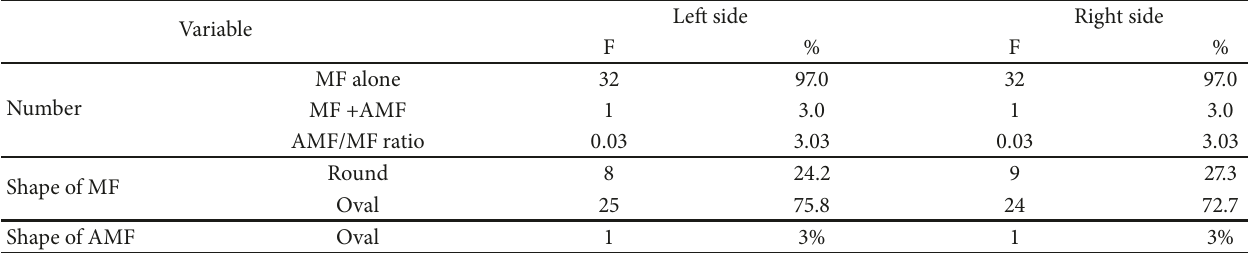
Table 1: Frequency distribution of number and shapes of MF and AMF and AMF/MF ratio in Zambian adult human mandibles (n=33). Variable